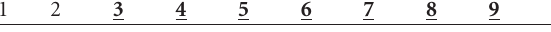
Table 1: A diagram and table describing the preparation of the explanted catheter. Note that 13 cm sections are implanted, but 3cm which is heat sealed and remains outside of the animal is removed prior to evaluation.